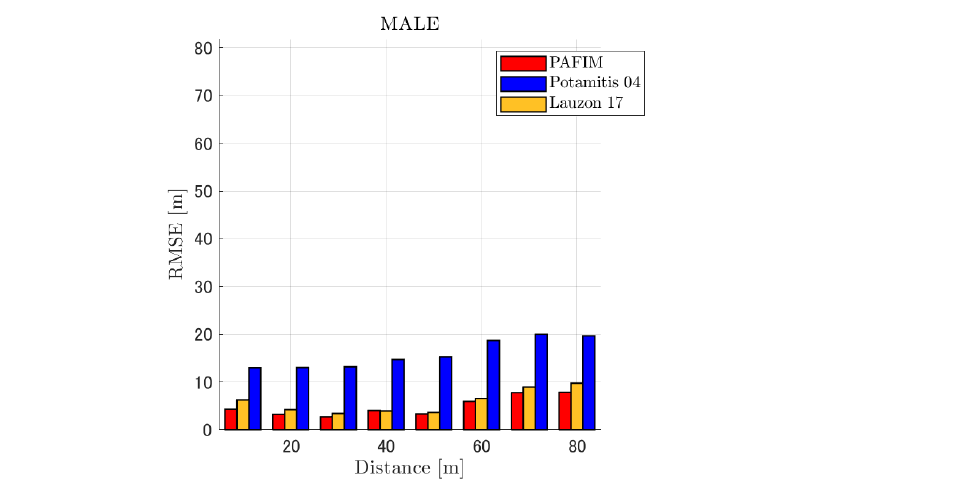
Figure 9. RMSE of tracking a stationary sound source emitting male voice (focusing on SNR = − 20 dB).